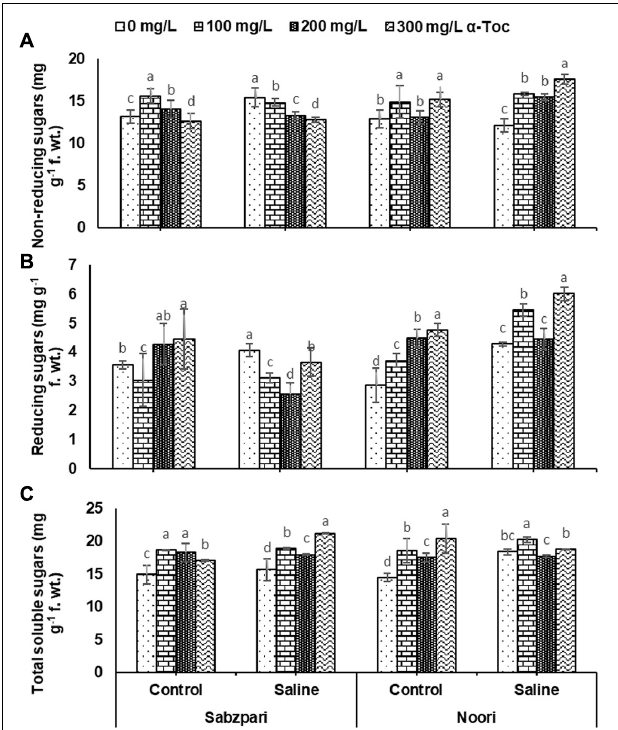
FIGURE 9 | Non-reducing sugars (A) , Reducing sugars (B) , Total soluble sugars (C) of okra varieties sprayed with different levels of α -tocopherol under saline conditions. Values represent means ± S.D. Significant differences among row spacing were measured by the least significant difference (LSD) at p > 0.05 and indicated by different letters.